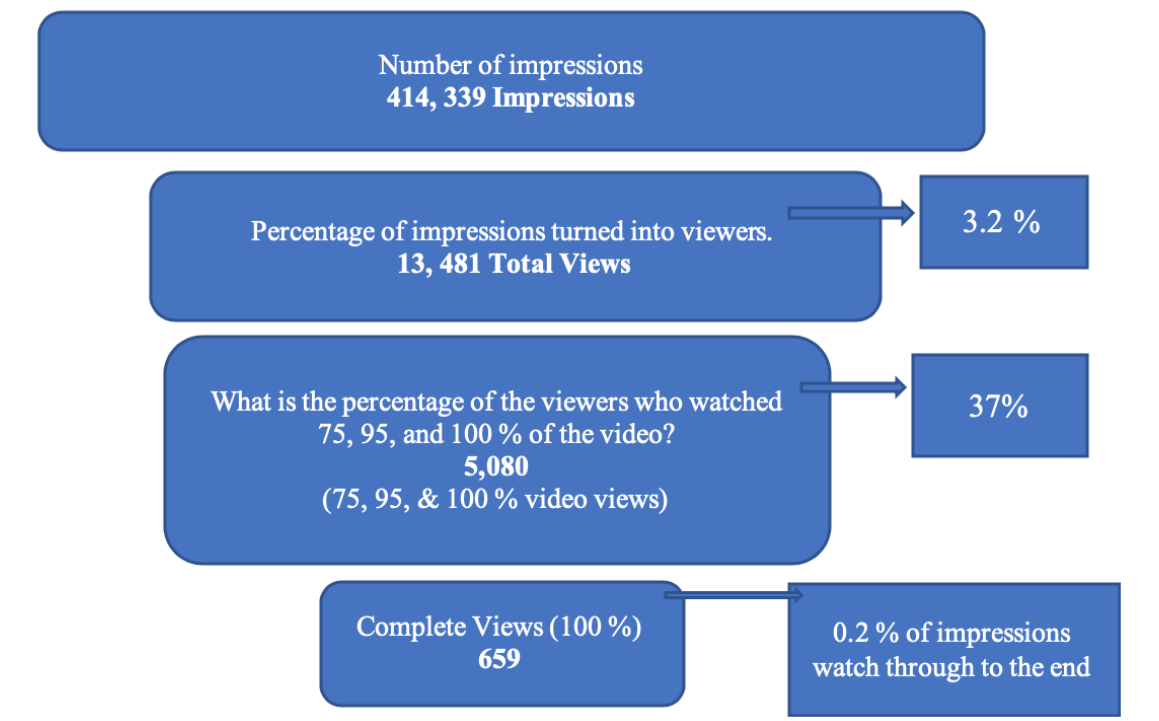
Figure 2. Engagement funnel example: Iraq and